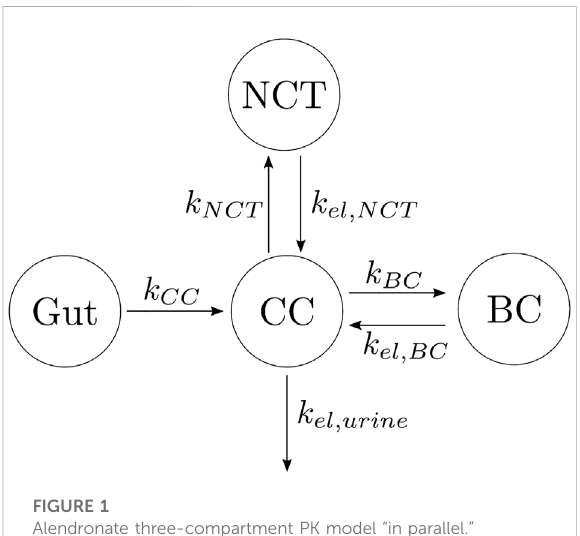
FIGURE 1 Alendronate three-compartment PK model “ in parallel.